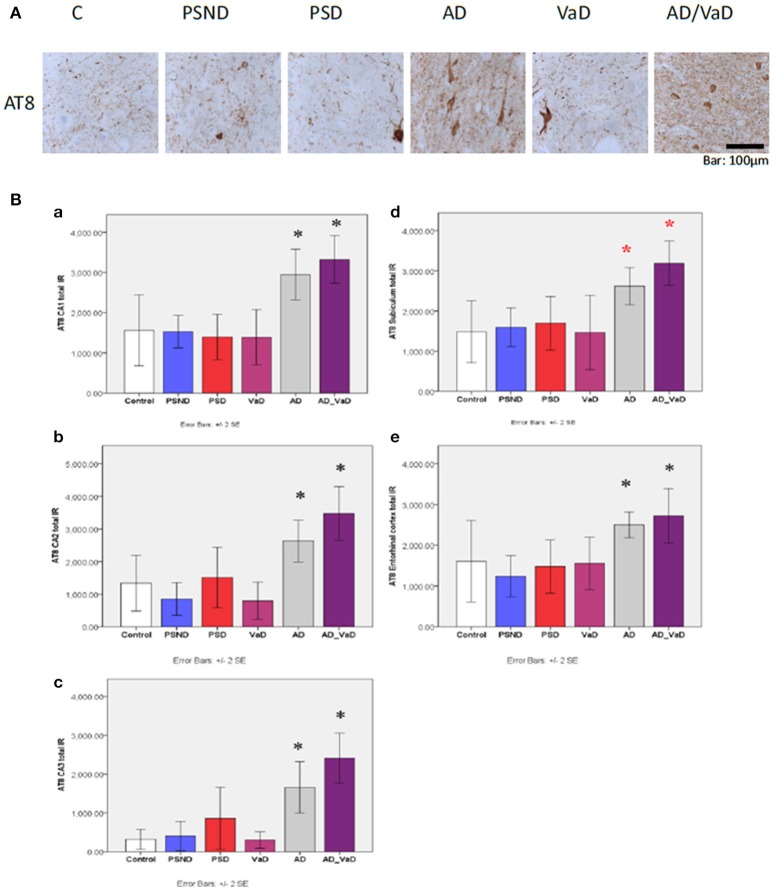
(A) Hyperphosphorylated tau (AT8) immunoreactivities showing neuropil threads, pretangles and tangles in hippocampal sub-region CAl. AT8 immunoreactivity is relatively higher in AD and AD_VaD compared to other groups. (B) Bar graph showing the distribution of AT8 IR across hippocampal sub-region. (a) CA1, (b) CA2, (c) CA3, (d) Subiculum (e) Entorhinal cortex in Controls. PSND. PSD. AD. VaD and AD_ VaD. Bars show ± 2 SEM *Mann Whitney U-test was used to compare means of each group. *p < 0.05; (in comparison with the control group). *(red) showed significant difference from PSND group.